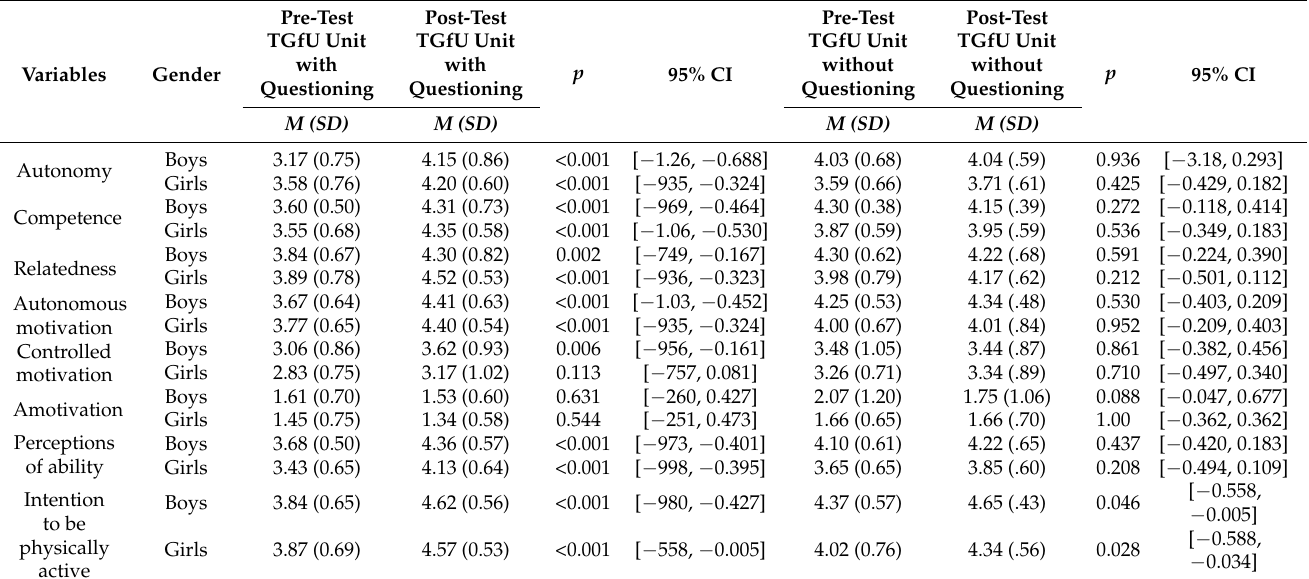
Table 2. Descriptive statistics and within-group analysis of each dependent